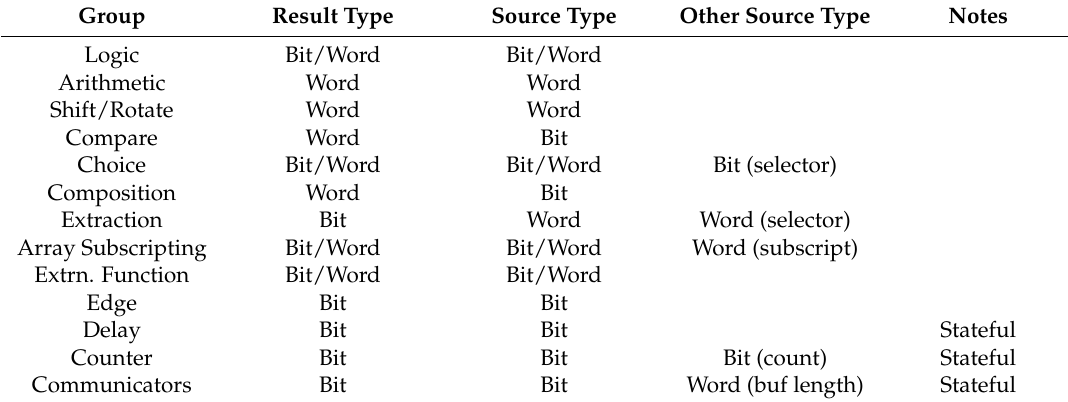
Table 1. Primitive Operator groups.